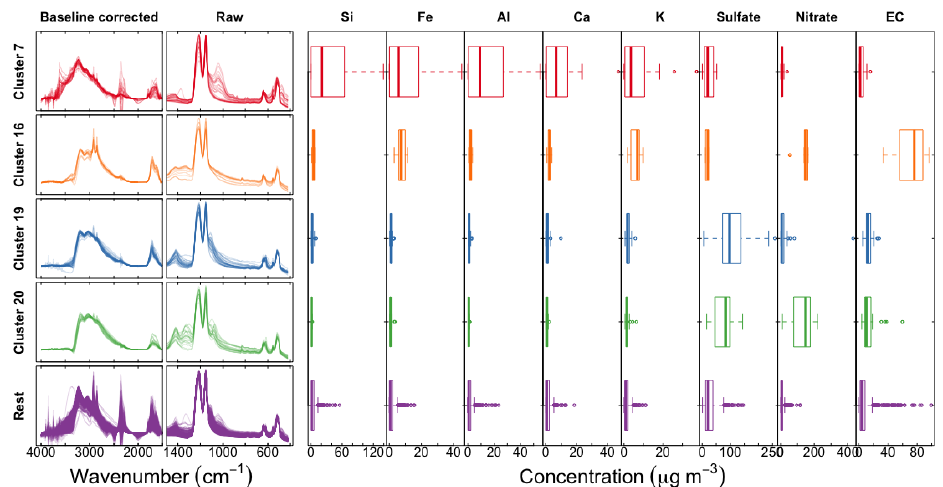
Figure 11. Left column shows scaled baseline-corrected spectra between 4000 and 1500cm − 1 ; middle column shows scaled raw spectra below 1500cm − 1 , and concentrations of PM constituents measured in the IMPROVE network: trace elements from X-ray fluorescence, inorganic ions (sulfate and nitrate) from ion chromatography, and elemental carbon from TOR